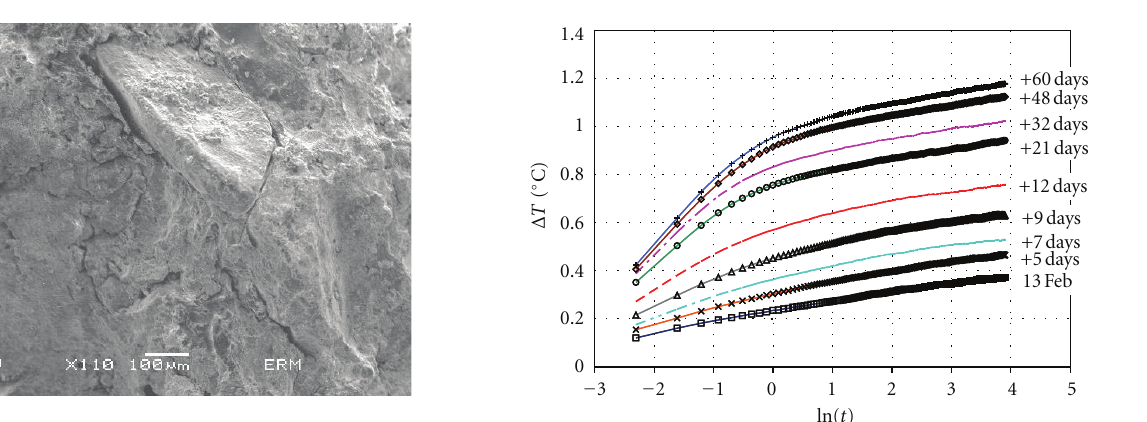
Figure 9: Evolution of the Δ T/ ln( t ) curves recorded on the compacted earth brick from 13 February (Feb) to April (+60